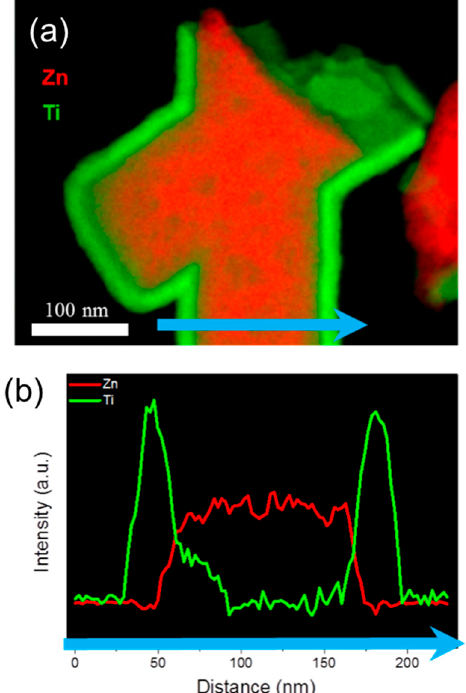
Figure 5. ( a ) 2D electron energy loss spectroscopy (EELS) elemental map of a junction of two wires, and ( b ) linescan across one nanowire, as marked in ( a ) by the blue arrow.